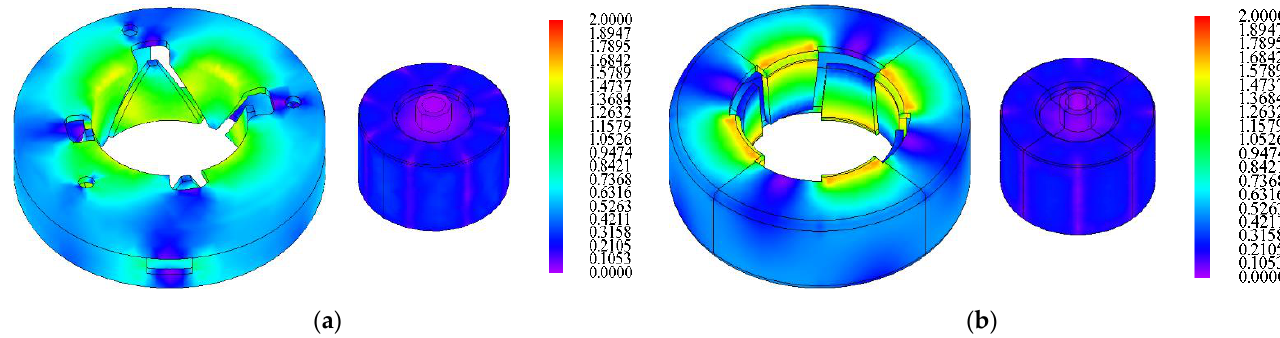
Figure 15. Magnetic flux densities of the base and proposed models in the no-load condition (left side, stator, rotor, and legend are shown): ( a ) base model; ( b ) proposed model.